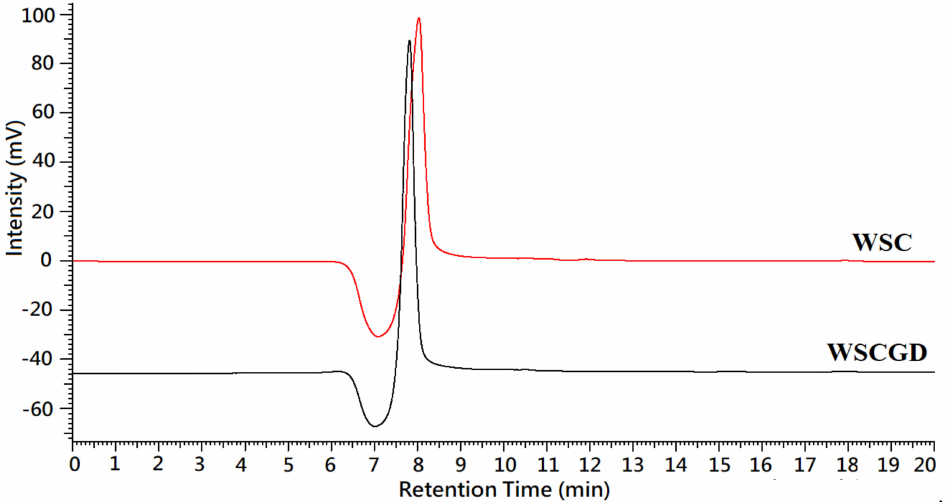
Figure 3. Typical high performance liquid chromatography size exclusion chromatography (HPLC SEC) profiles of WSC and